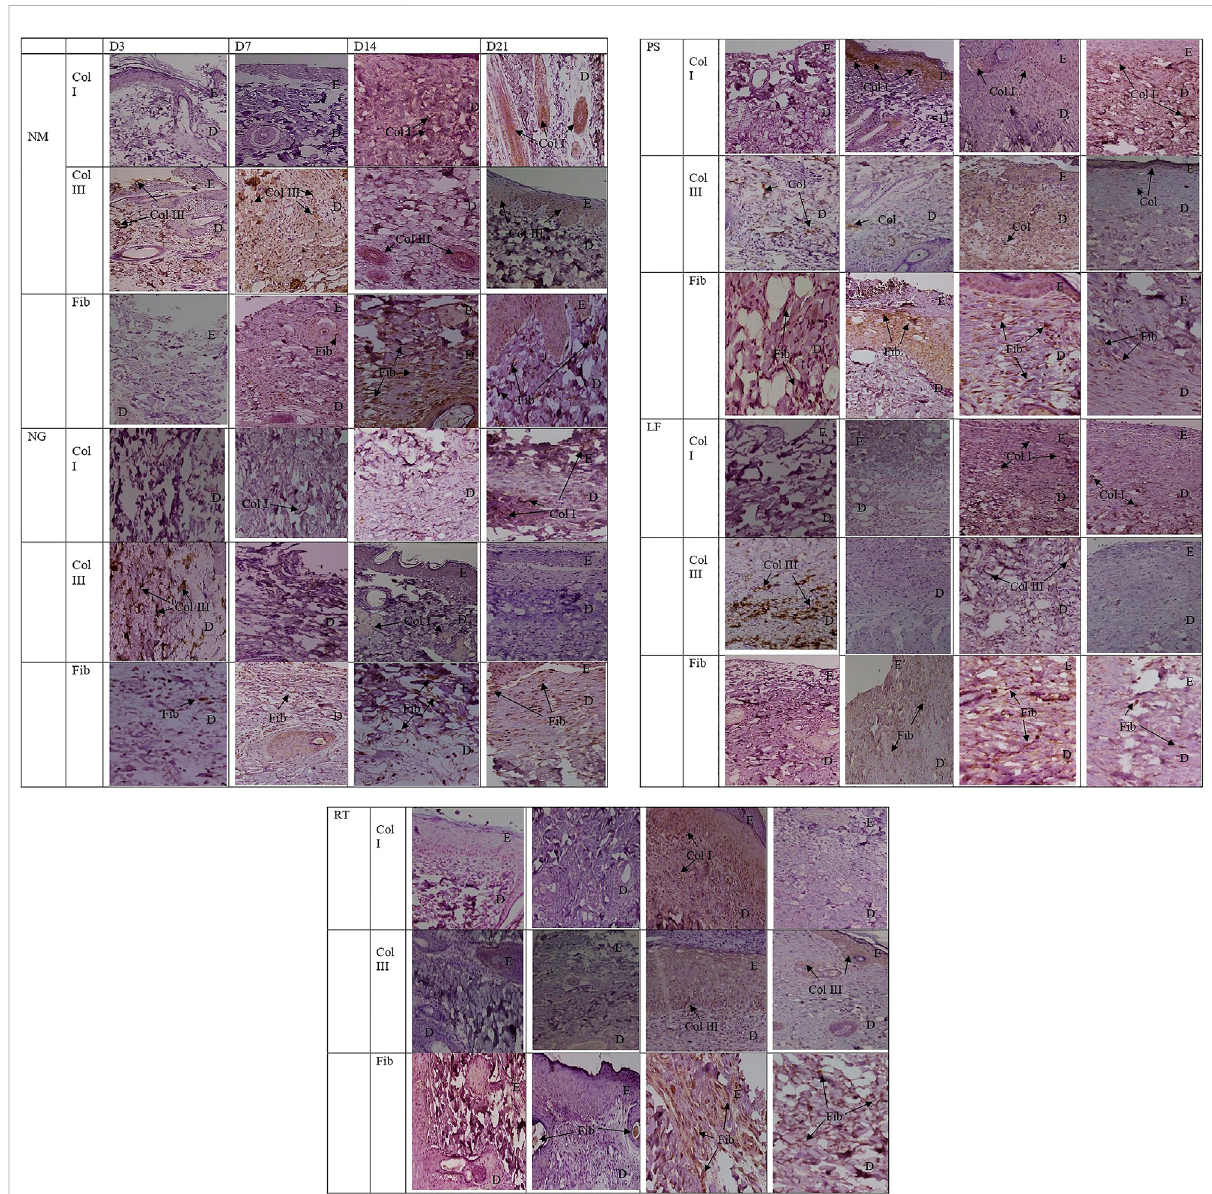
FIGURE 9 Histopathological view of the burn wounds at Day 3, 7, 14 and 21. Immunohistochemistry staining for collagen I, collagen III and fi broblast, at ×200 magni fi cation. Light brown staining represents positive immunostaining. In most of the groups, collagen III was scant or moderate at day 3, whilecollagenIwereabudantatday21.Fibroblastwerescantatday3andwereimprovedtomoderateandabundantinmostofthegroupsatday21. E: epidermis; D: Dermis, Fib: Fibroblast; Col I: Collagen type I, Col III: Collagen type III. NM: normal control group, NG: negative control group, PS: positive control group, LF: LPVa leaf-treated group, RT: LPVa root-treated